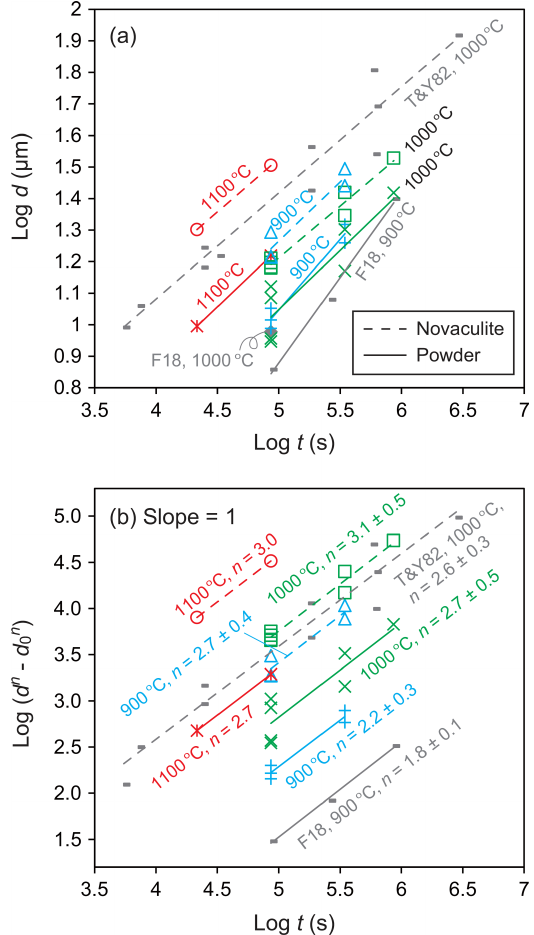
Figure 8. Grain sizes at a pressure of 1.5GPa and for different dura- tions; ( a ) log d ; ( b ) log (d n − d n ) with changing n values to obtain 0 slopes = 1. Grain sizes in micrometers (µm). Also shown are data from Tullis and Yund (1982) (denoted as T&Y82) for novaculite and from Fukuda et al. (2018) (F18) for powder. Figure 10. Dependence of temperature on grain size. Pressure of 1.5GPa. Grain sizes in micrometers (µm) and water fugacity in megapascals